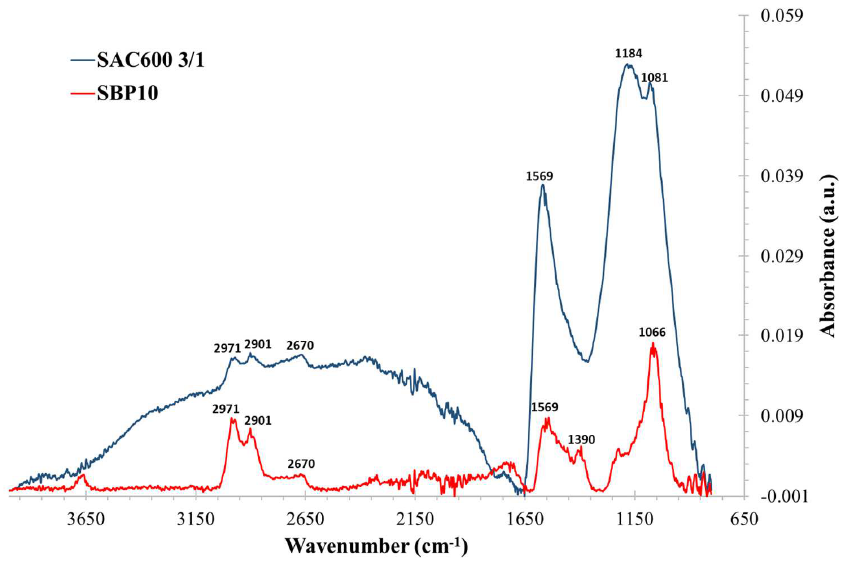
Figure 4. FTIR spectra of Sargassum based activated carbons at lab and pilot conditions. Table 3. Identification of absorption peaks of FTIR spectra for both AC